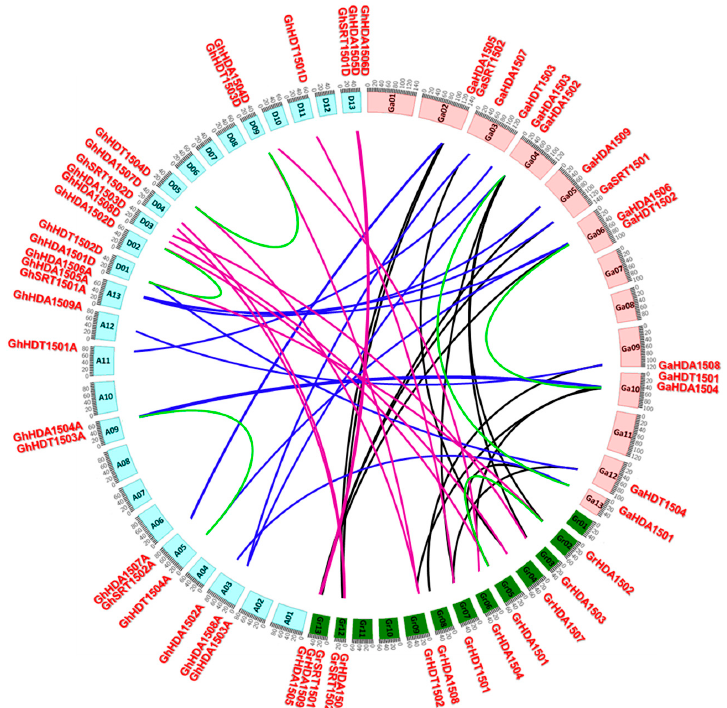
Figure 3. Chromosomal distribution and gene duplication of HDACs in G. hirsutum , G. raimondii , and G. arboretum . The chromosome numbers are indicated in boxes and represented as A1–A13 and D1-D13 for G . hirsutum , Ga1–Ga13 for G. arboretum , and Gr1–Gr13 for G. raimondii . Segment duplication of the HDAC genes is represented using green, while blue and purple represent the orthologous gene pairs between tetraploids and diploids, and black lines represent the orthologous genes pairs between diploid species, respectively.